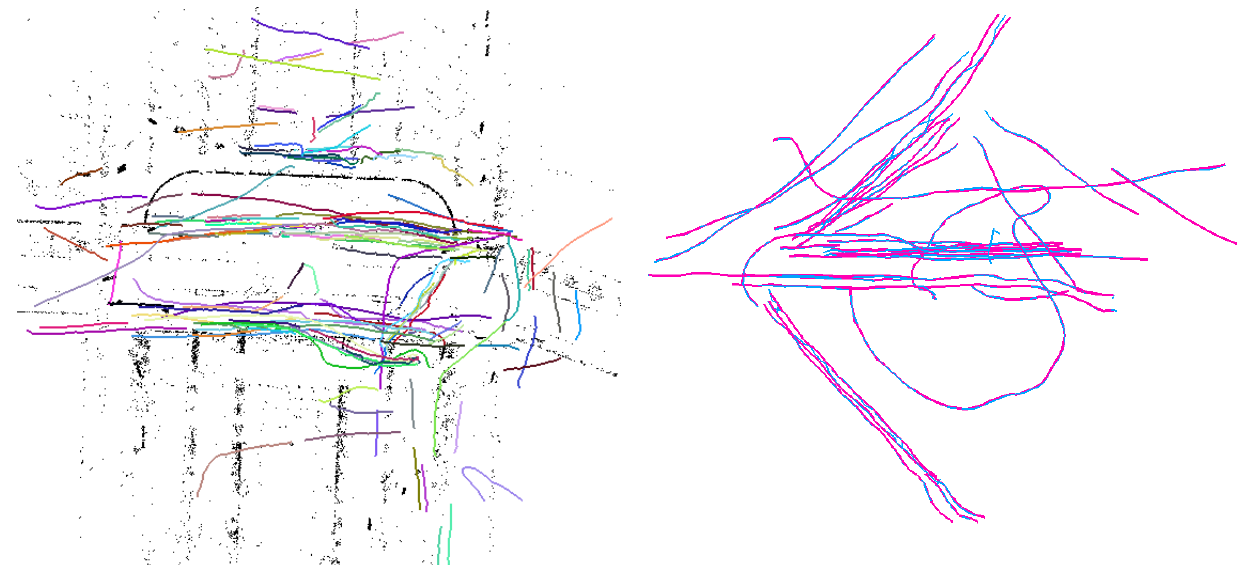
Figure 8: Comparison between the detected tracks (cyan) and the ground truth